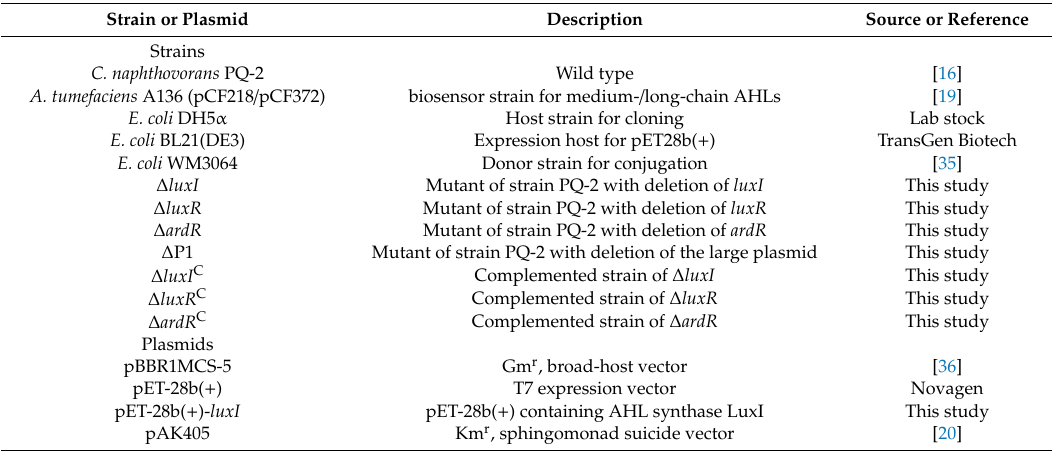
Table 1. Strains and plasmids used in this